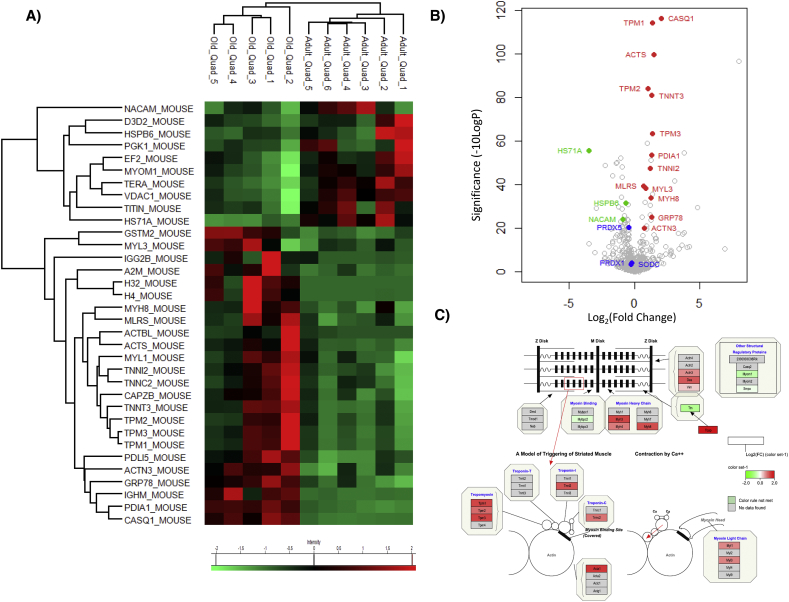
Label free proteomics of quadriceps from adult and old mice (A) Heatmap of significantly changed proteins (fold change >1.5 and –10logP > 20 equivalent to P < 0.01) (B) Volcano plot of quantified protein changes with age and significance, proteins highlighted in red are significantly increased with age, proteins highlighted in green are decreased with age (C) Pathway analysis of quantitative proteomic data reveals an upregulation of proteins involved in muscle contraction.